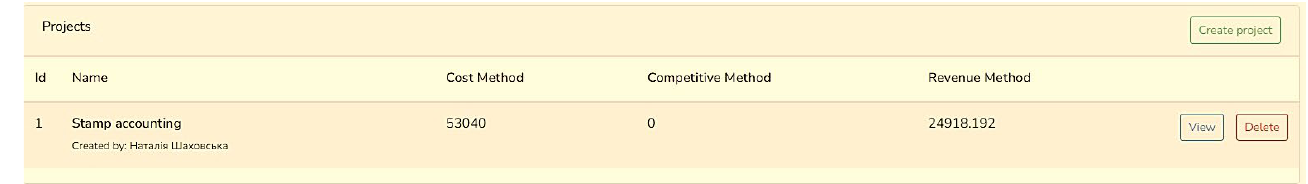
Figure 12. Web page for R&D product cost estimation.